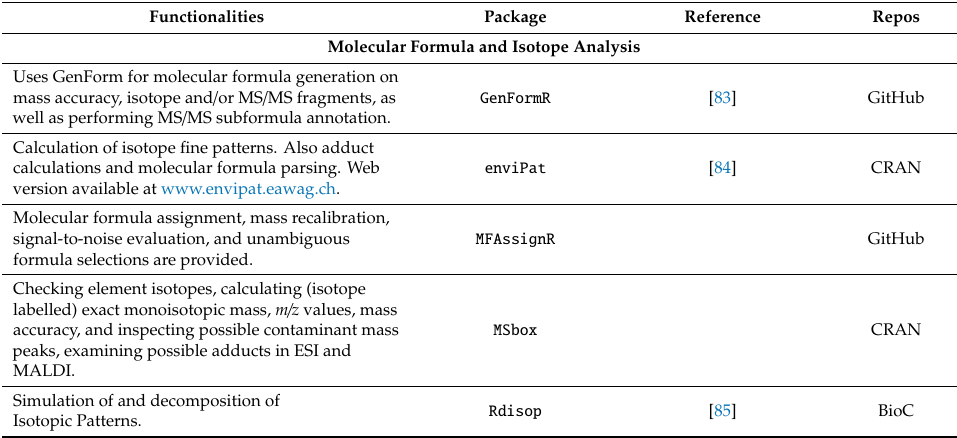
Table 2. R packages for ion species grouping, annotation, molecular formula generation and accurate mass